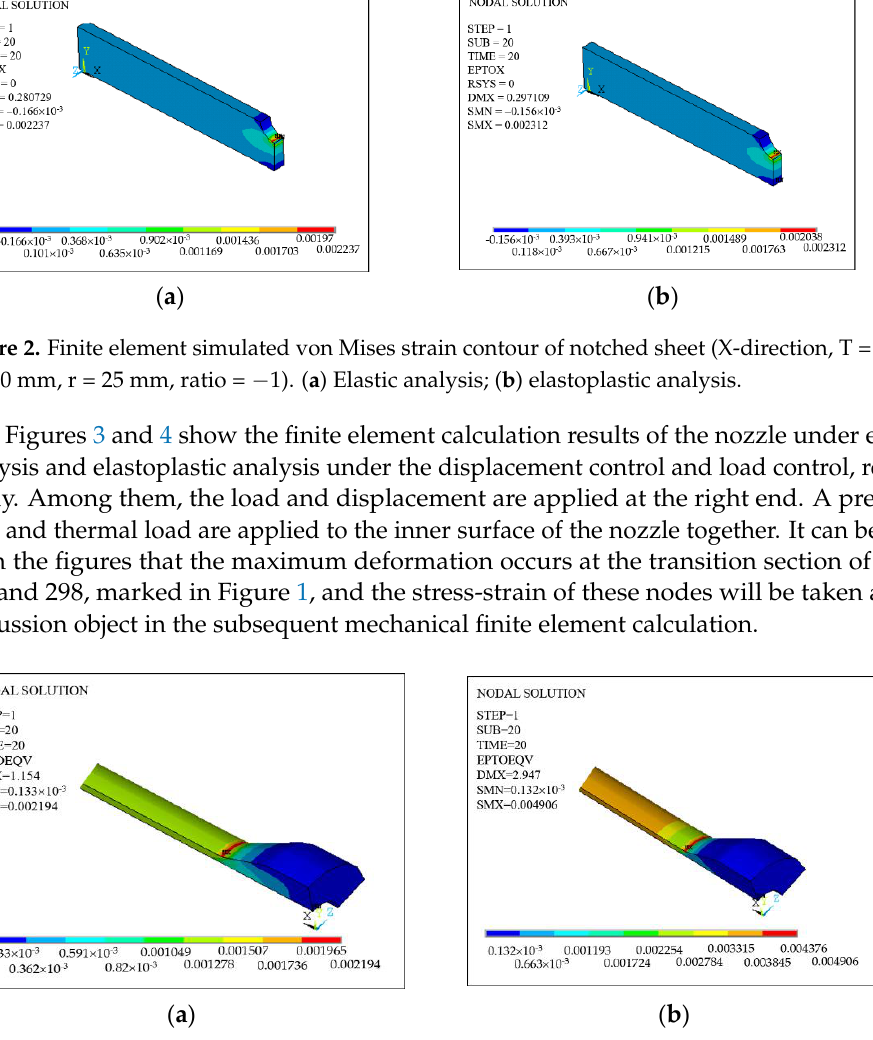
Figure 3. Finite element simulated von Mises strain contour of nozzle under axial load. ( a ) Elastic analysis; ( b ) elastoplastic analysis.